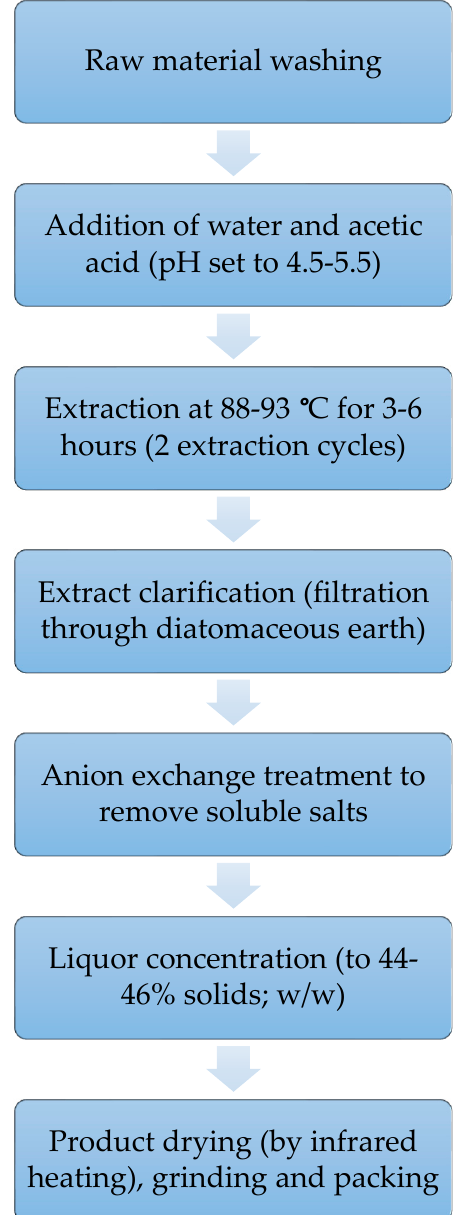
Scheme 1. Basic steps of the fish gelatine production process